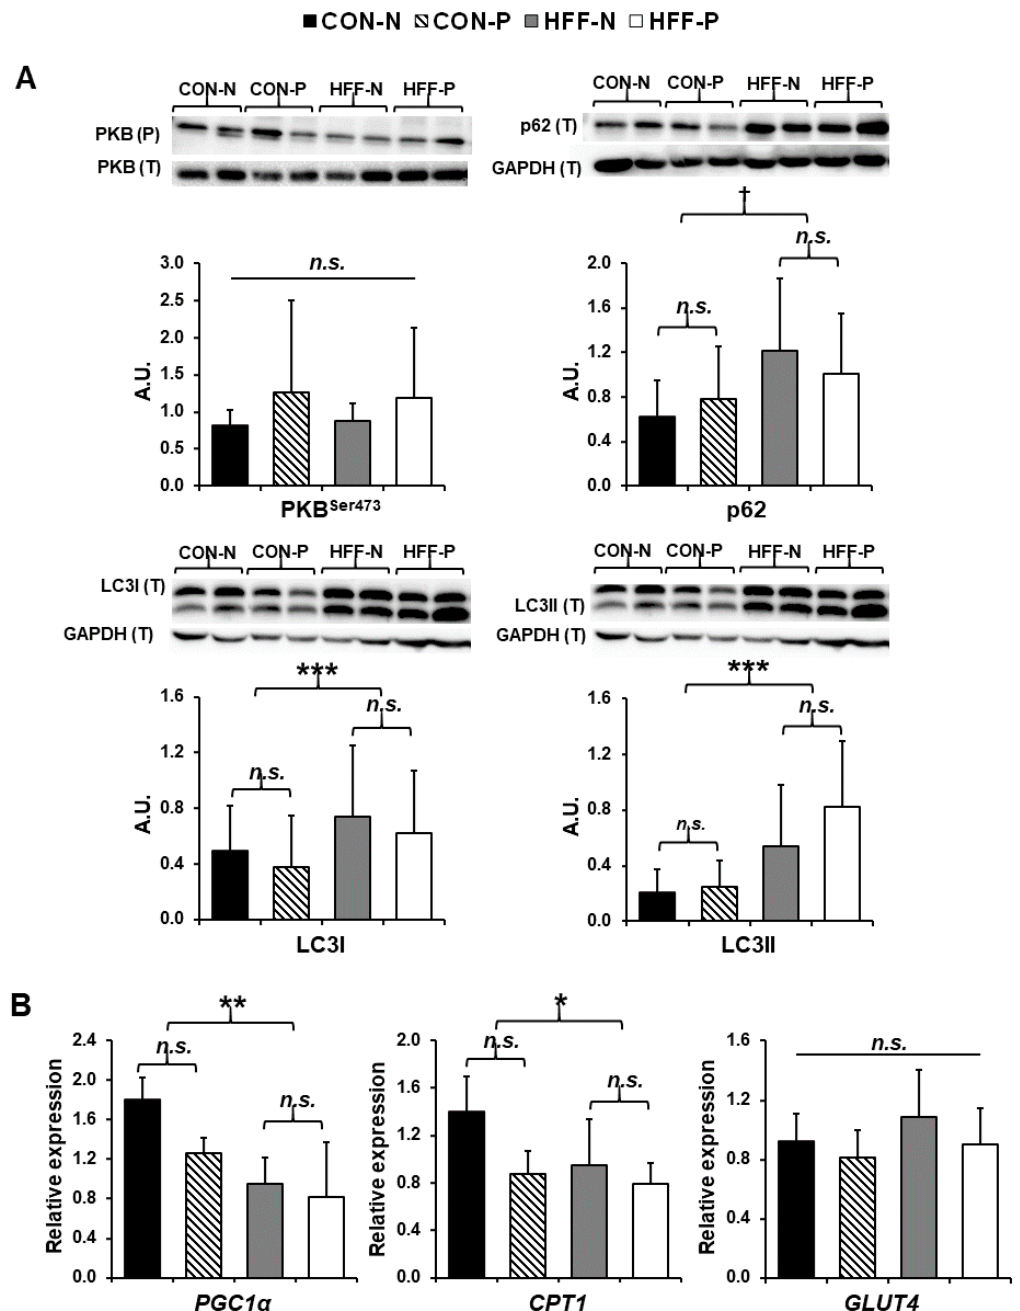
Figure 3. Increased autophagy and decreased lipid metabolism in skeletal muscle of juvenile Iberian pigs fed a high- fructose, high-fat diet (HFF) in the absence of insulin resistance. ( A ) Western blots of microtubule-associated protein 1 light chain 3 I (LC3I), microtubule-associated protein 1 light chain 3 II (LC3II), ubiquitin-binding protein (p62), and the ratio of phosphorylated to total protein kinase B (PKB Ser 473) in longissimus dorsi muscle indicating an